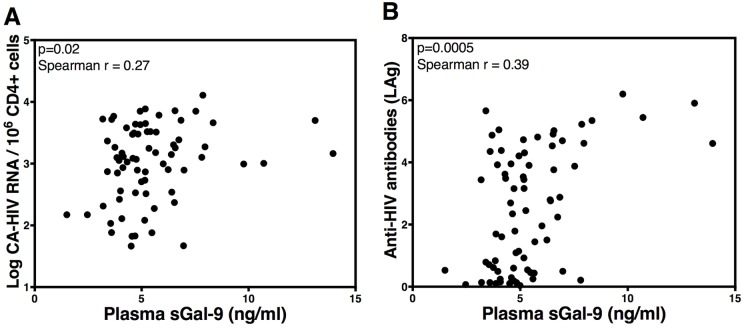
sGal-9 levels correlate with measures of HIV transcription and viral production in vivo.Correlations between levels of soluble Gal-9 and (A) levels of HIV cell-associated RNA, and (B) anti-HIV-1 antibodies in the plasma of 72 HIV-infected ART-suppressed individuals. Correlations were evaluated using Spearman's rank correlation coefficient tests.